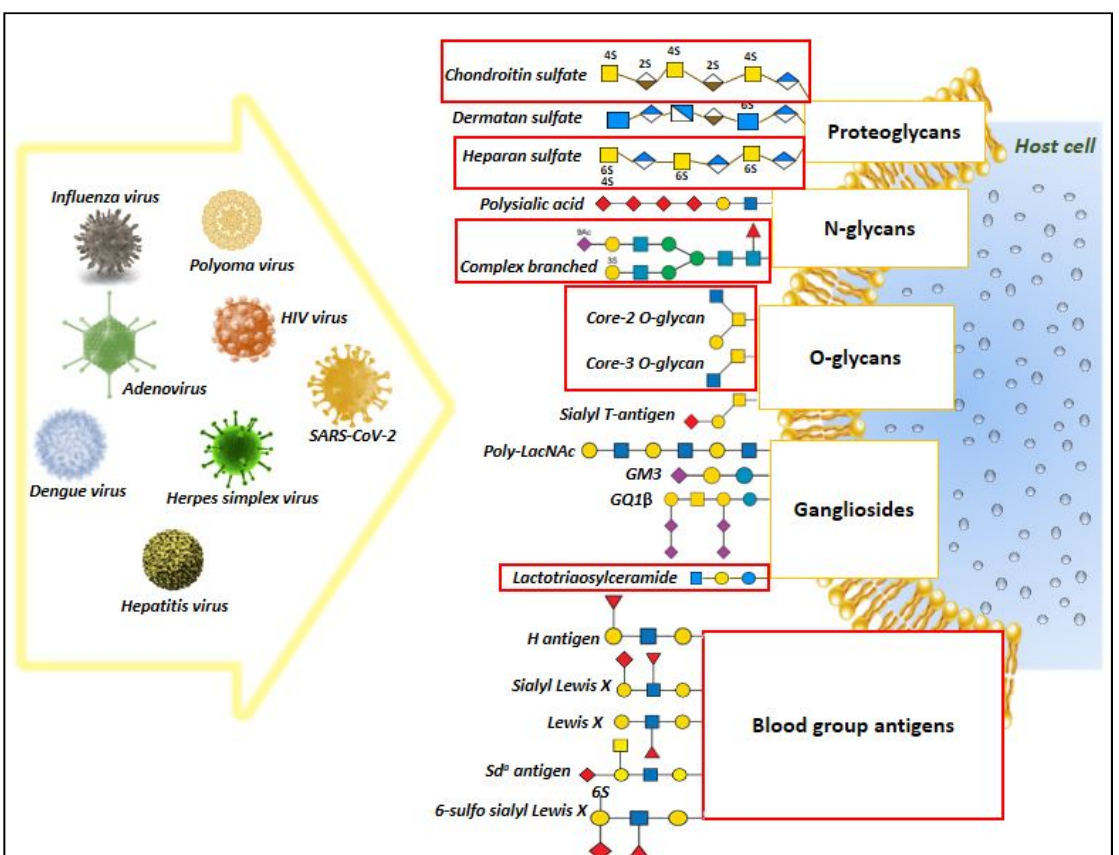
Figure 4. Overview of diverse glycan epitopes that act as host ligands for pathogenic virus attachment and infection. The figure represent the results generated from our manual literature search highlighting the involvement of glycan structures as host ligands for major pathogenic viruses. Among these, the red highlighted boxes represent potential glycan epitope structures that was predicted to change in response to SARS-CoV-2 infection, based on the transcriptomic data analysis, thus suggesting a possibility of shared features in glycan structures during viral infection that might aid in viral attachment and infection.